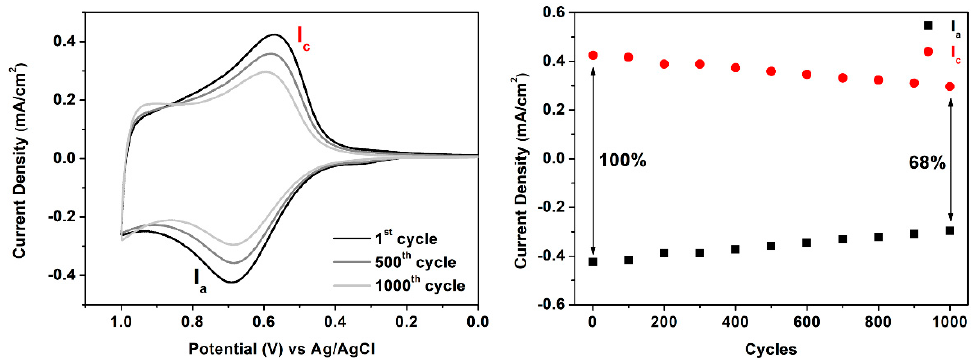
Figure 8. CV diagrams of ( a ) P1 and ( b ) P2 on the ITO-coated glass slide in 0.1 M Bu 4 NClO 4 / MeCN at a scan rate of 50 mV/s.